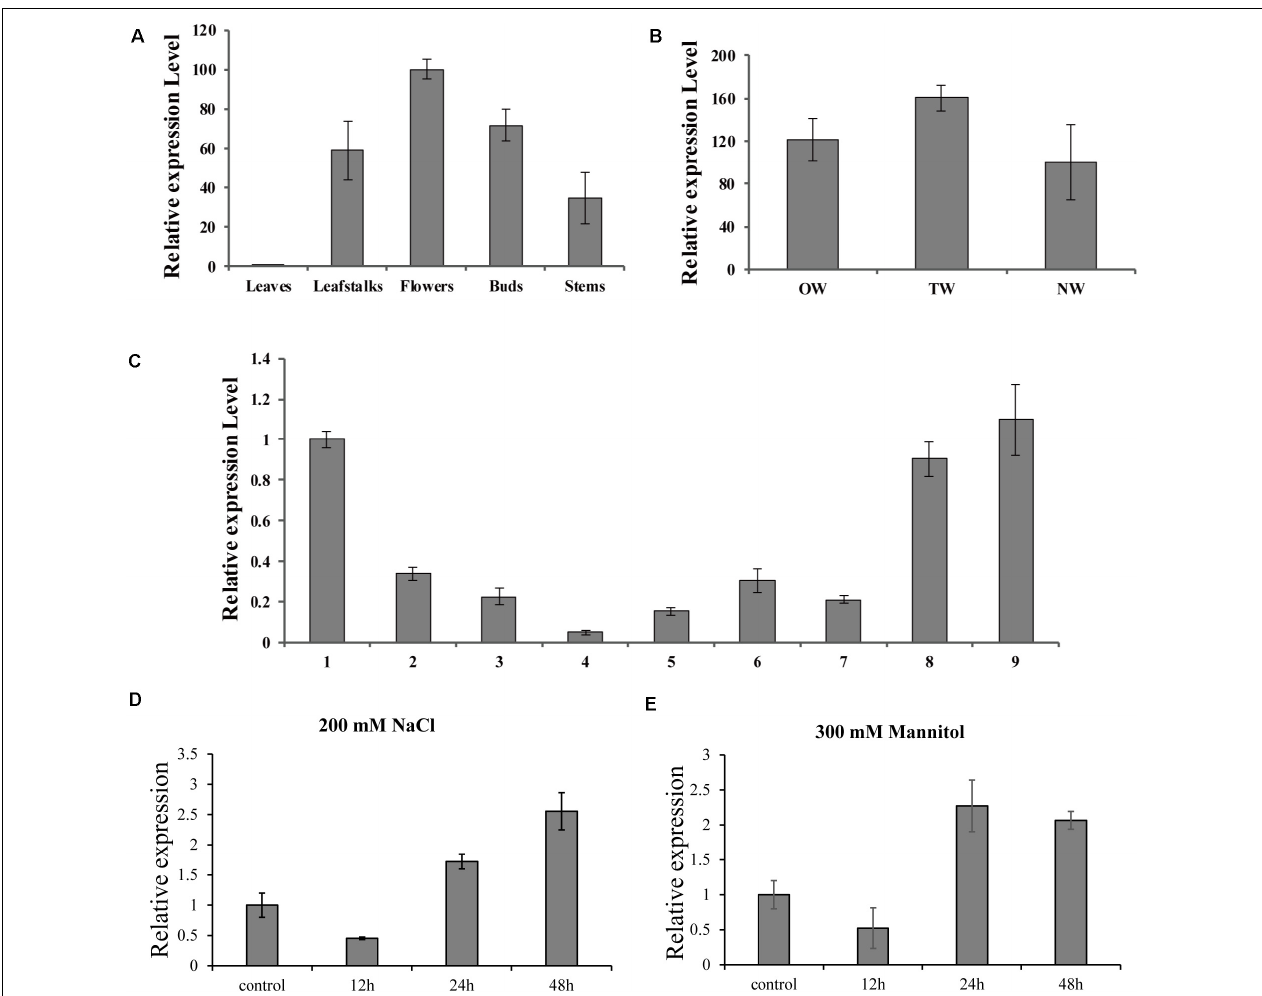
FIGURE 3 | Real-time RT-PCR expression analysis of BpMYB4. (A) Real-time RT-PCR analysis of BpMYB4 expression in different tissues. (B) Real-time RT-PCR expression analysis of BpMYB4 in OW (opposite wood), TW (tension wood) and NW (normal wood). (C) Real-time RT-PCR analysis of BpMYB4 expression in birch xylem at different growth stages (Numbers 1–9 indicate different months). (D) Real-time RT-PCR analysis of BpMYB4 expression in birch under different time stresses of 200 mM NaCl. (E) Real-time RT-PCR analysis of BpMYB4 expression in birch under different time stresses of 300 mM Mannitol. Error bars represent standard error for three